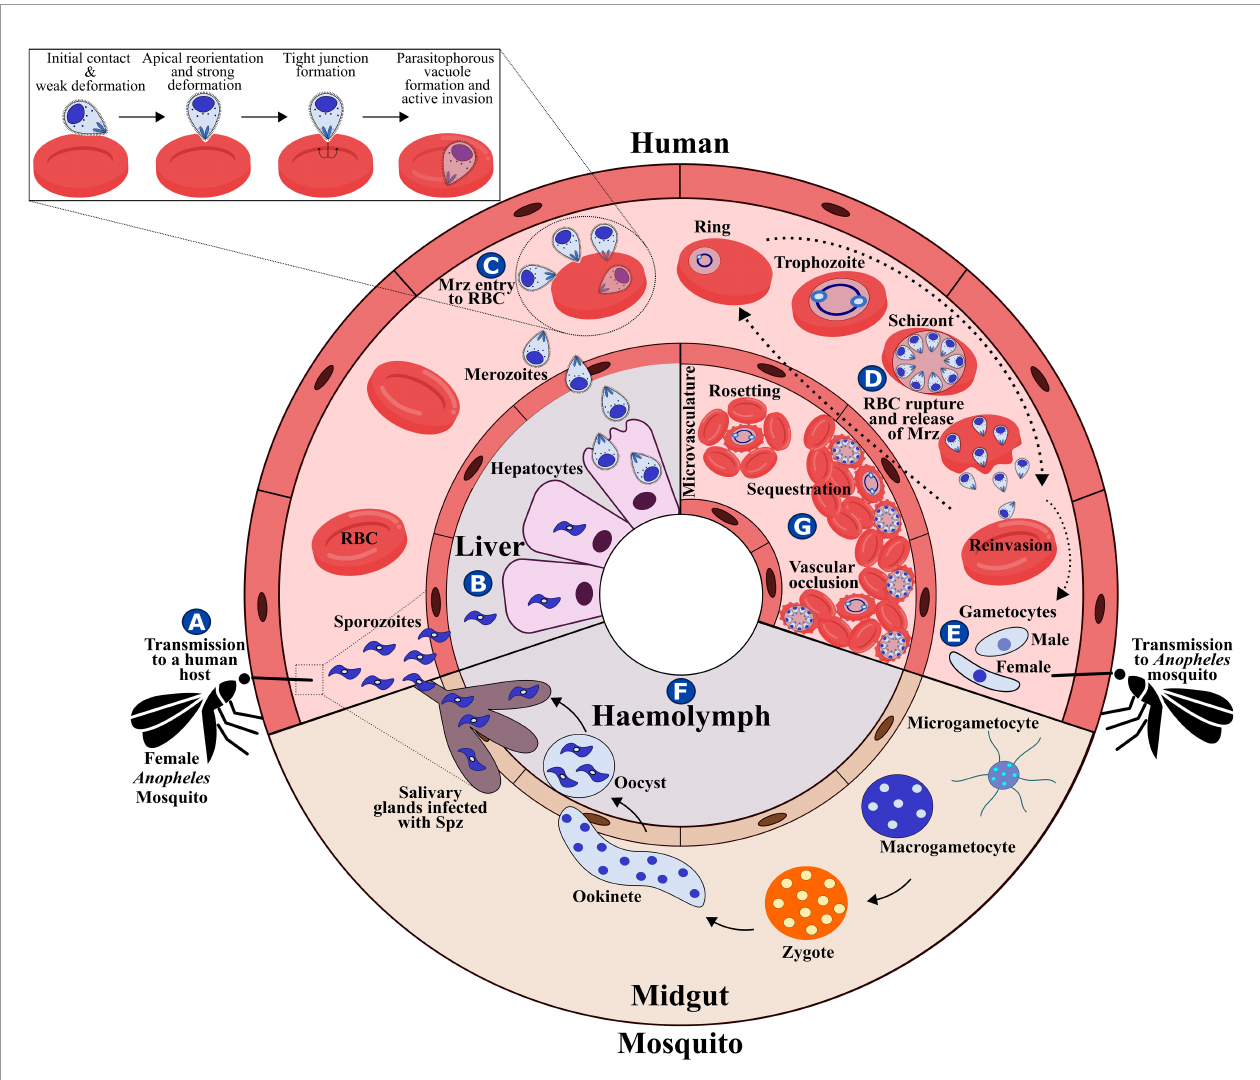
FIGURE 1 | P. falciparum lifecycle. (A) P. falciparum Spz inoculation into a human host by a female Anopheles mosquito. (B) Spz entry to hepatocytes, Spz maturation into schizonts and Mrz release. (C) Mrz entry into RBCs. (D) Asexual multiplication within RBCs. (E) Some parasites differentiate to sexual stages; gametocytes are ingested by an Anopheles mosquito during a blood meal. (F) Sporogonic cycle. (G) Rosetting, sequestration and vascular